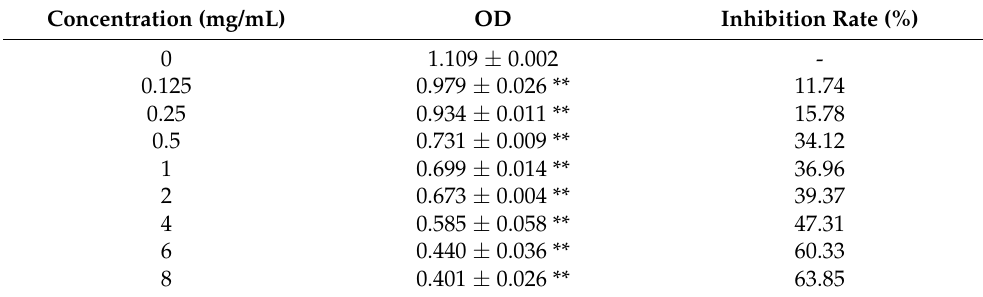
Table 5. Growth inhibition of S180 cells (** indicates that the difference is extremely significant compared with the blank group ( p < 0.01)).